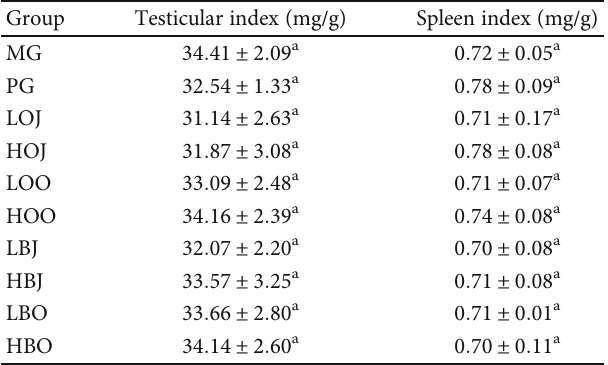
Table 1: E ff ect of di ff erent treatments on the organ index. Group Testicular index